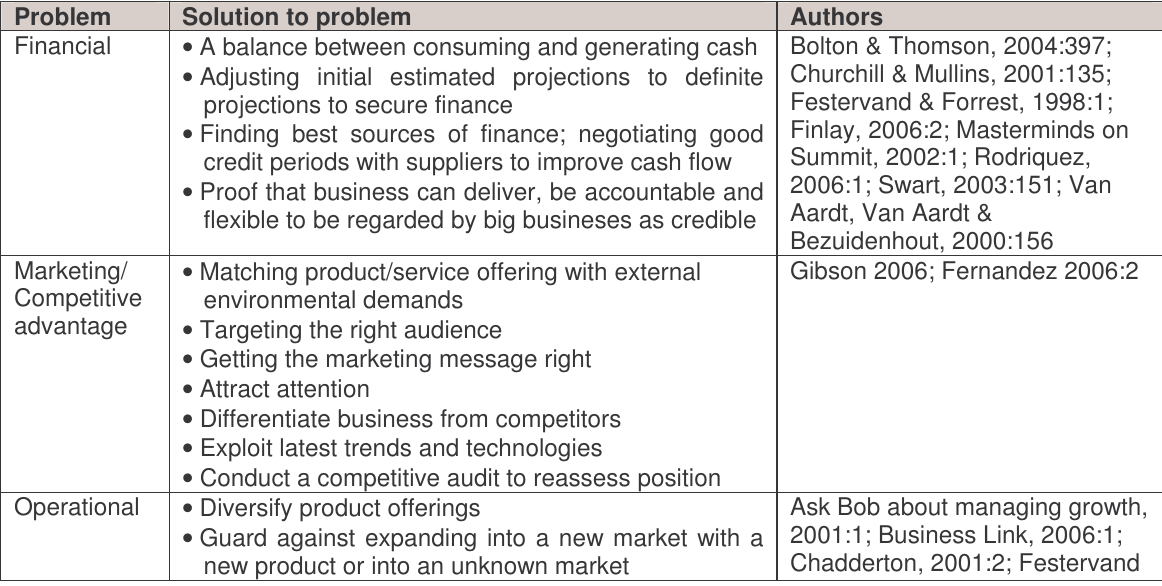
Table 1:Suggested solutions for solving small business growth problems